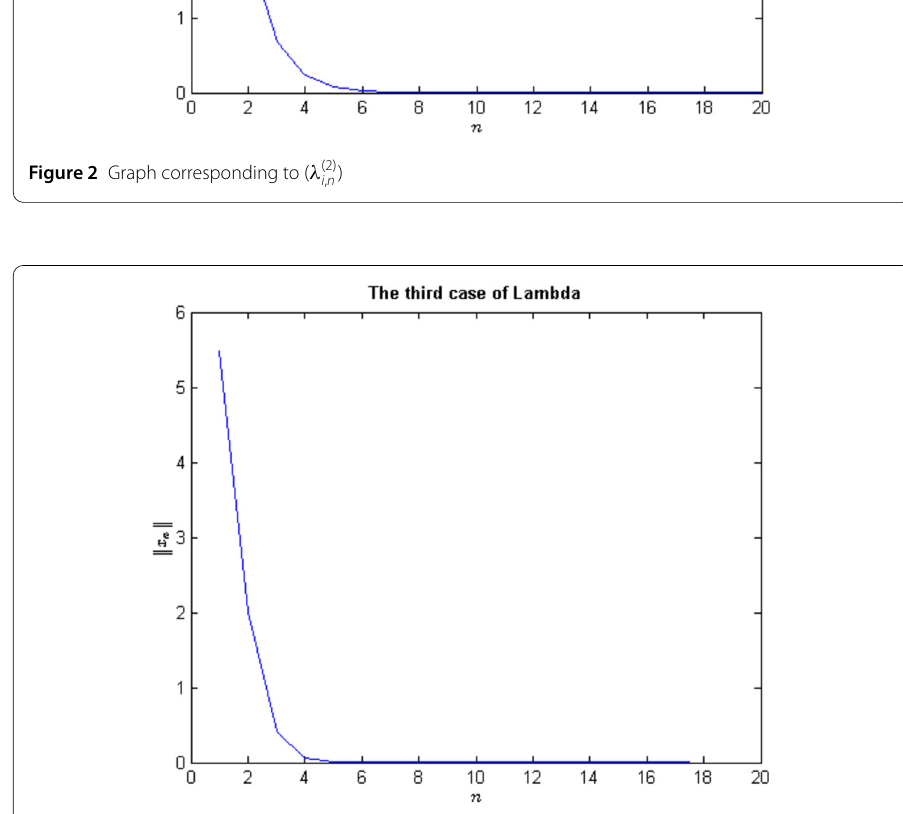
Figure 3 Graph corresponding to ( λ (3)